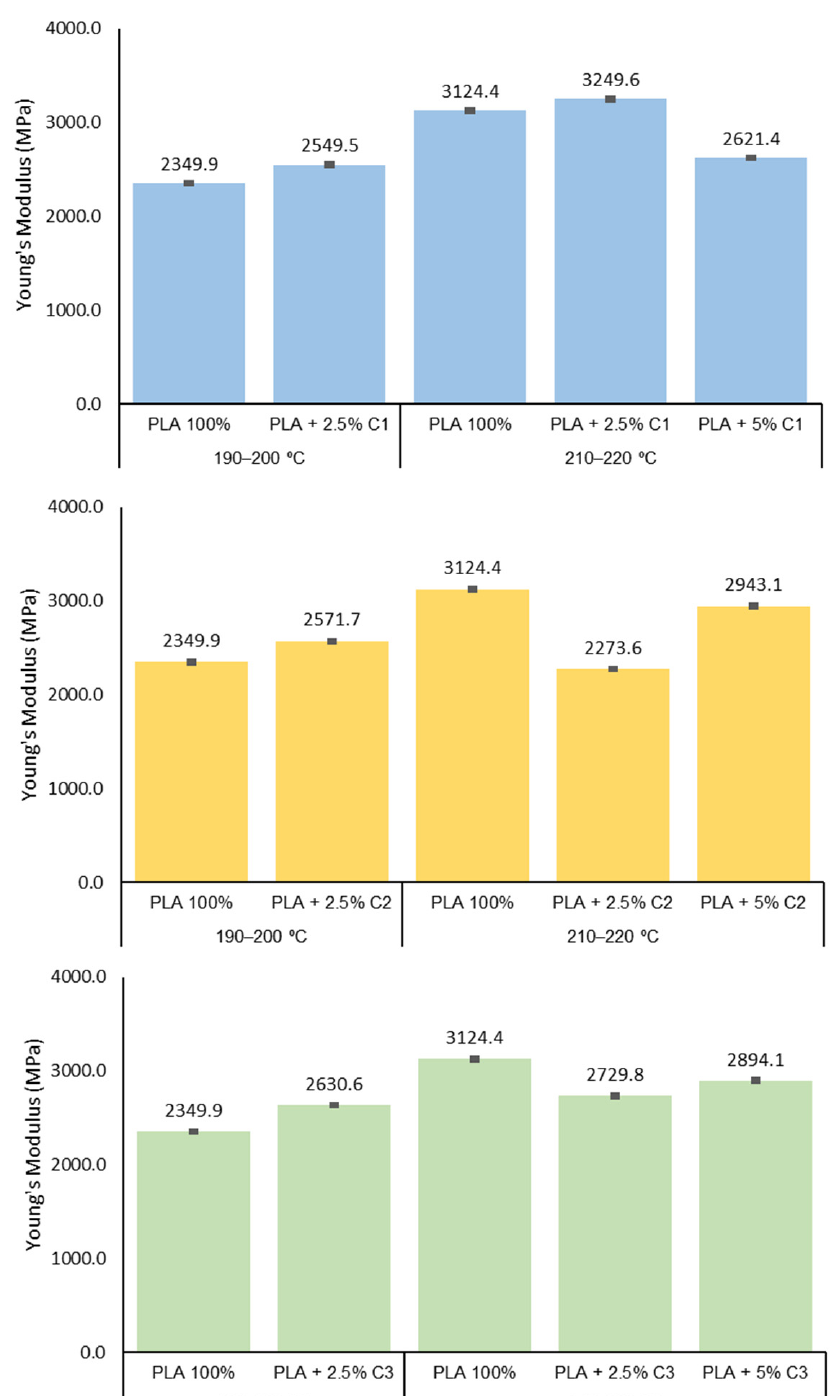
Figure 7. Young’s Modulus of PLA 100%, PLA + 2.5% and PLA + 5% concentrations of compatibilizer samples extruded at 190–200 ° C and 210–220 ° C.